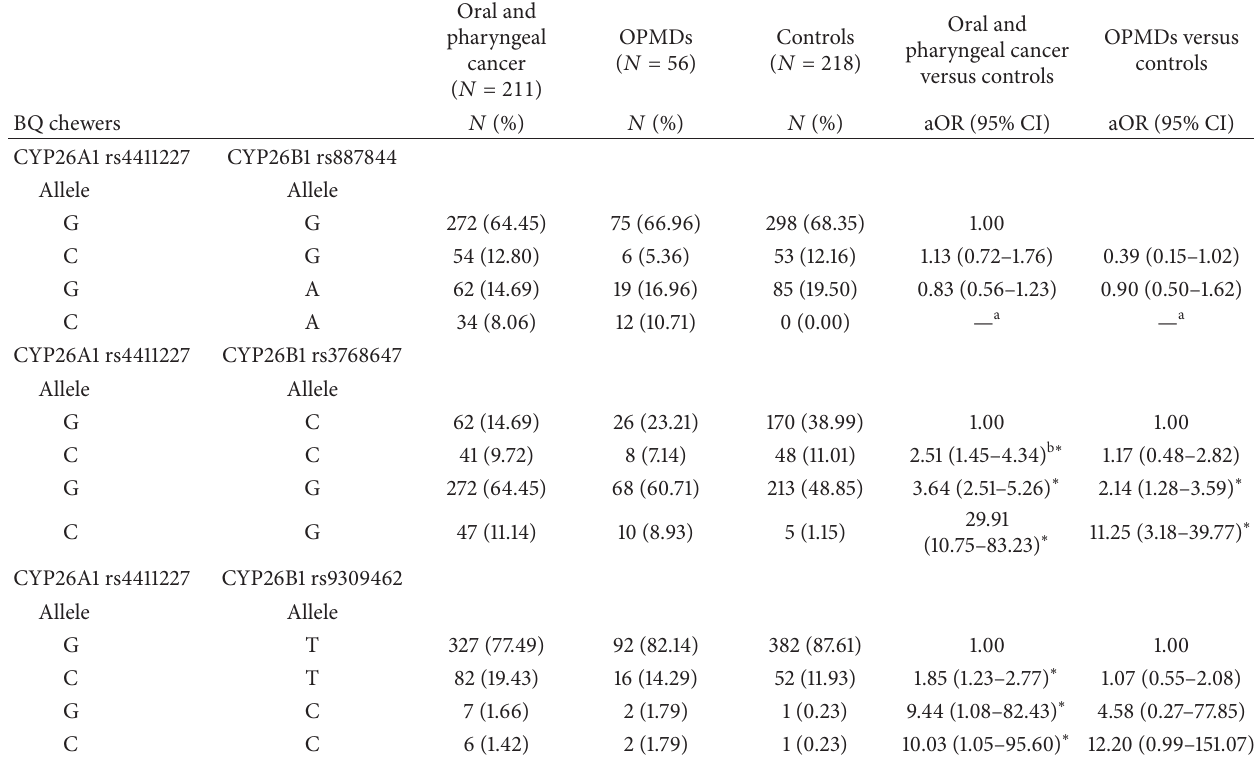
Table 3: Joint effects between CYP26A1 and CYP26B1 polymorphisms among malignant oral disorders patients and control